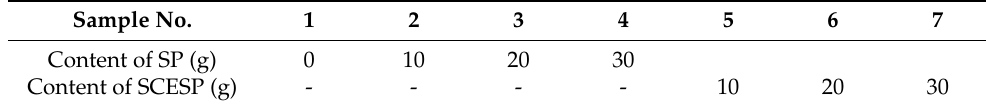
Table 5. Contents of SP and SCESP in modified asphalt.